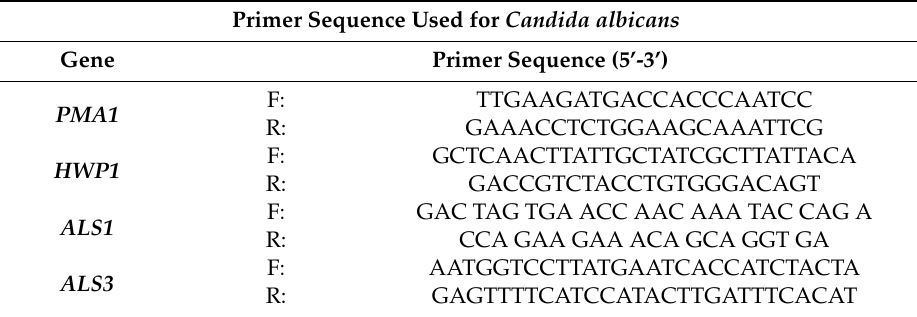
Table 2. Candida albicans forward (F) and reverse (R) primers used for qRT-PCR [65]. Primer Sequence Used for Candida